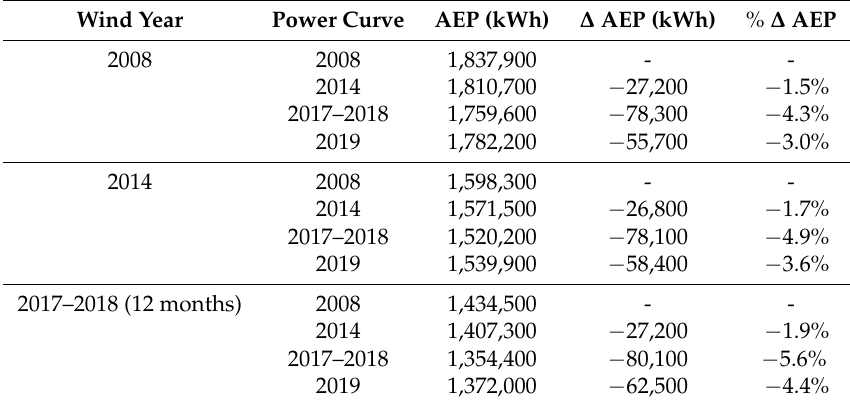
Table 7. Comparisons of AEP variation with power curve and gearbox replacement. Wind